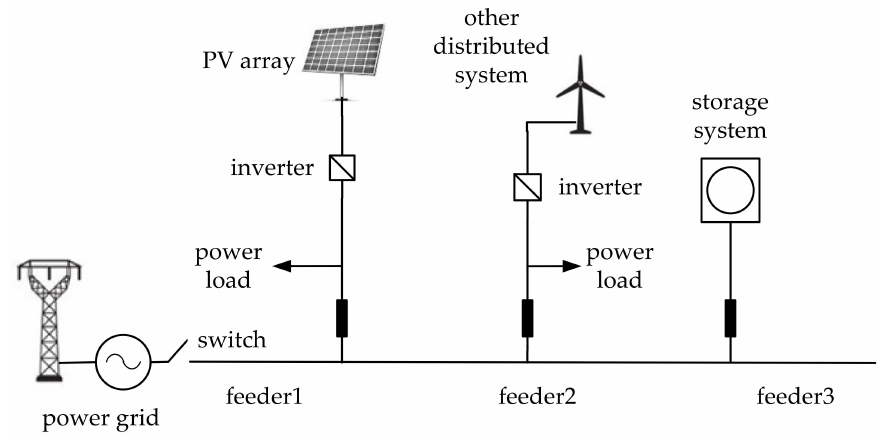
Figure 2. Micro-grid structure with distributed power-generation systems.